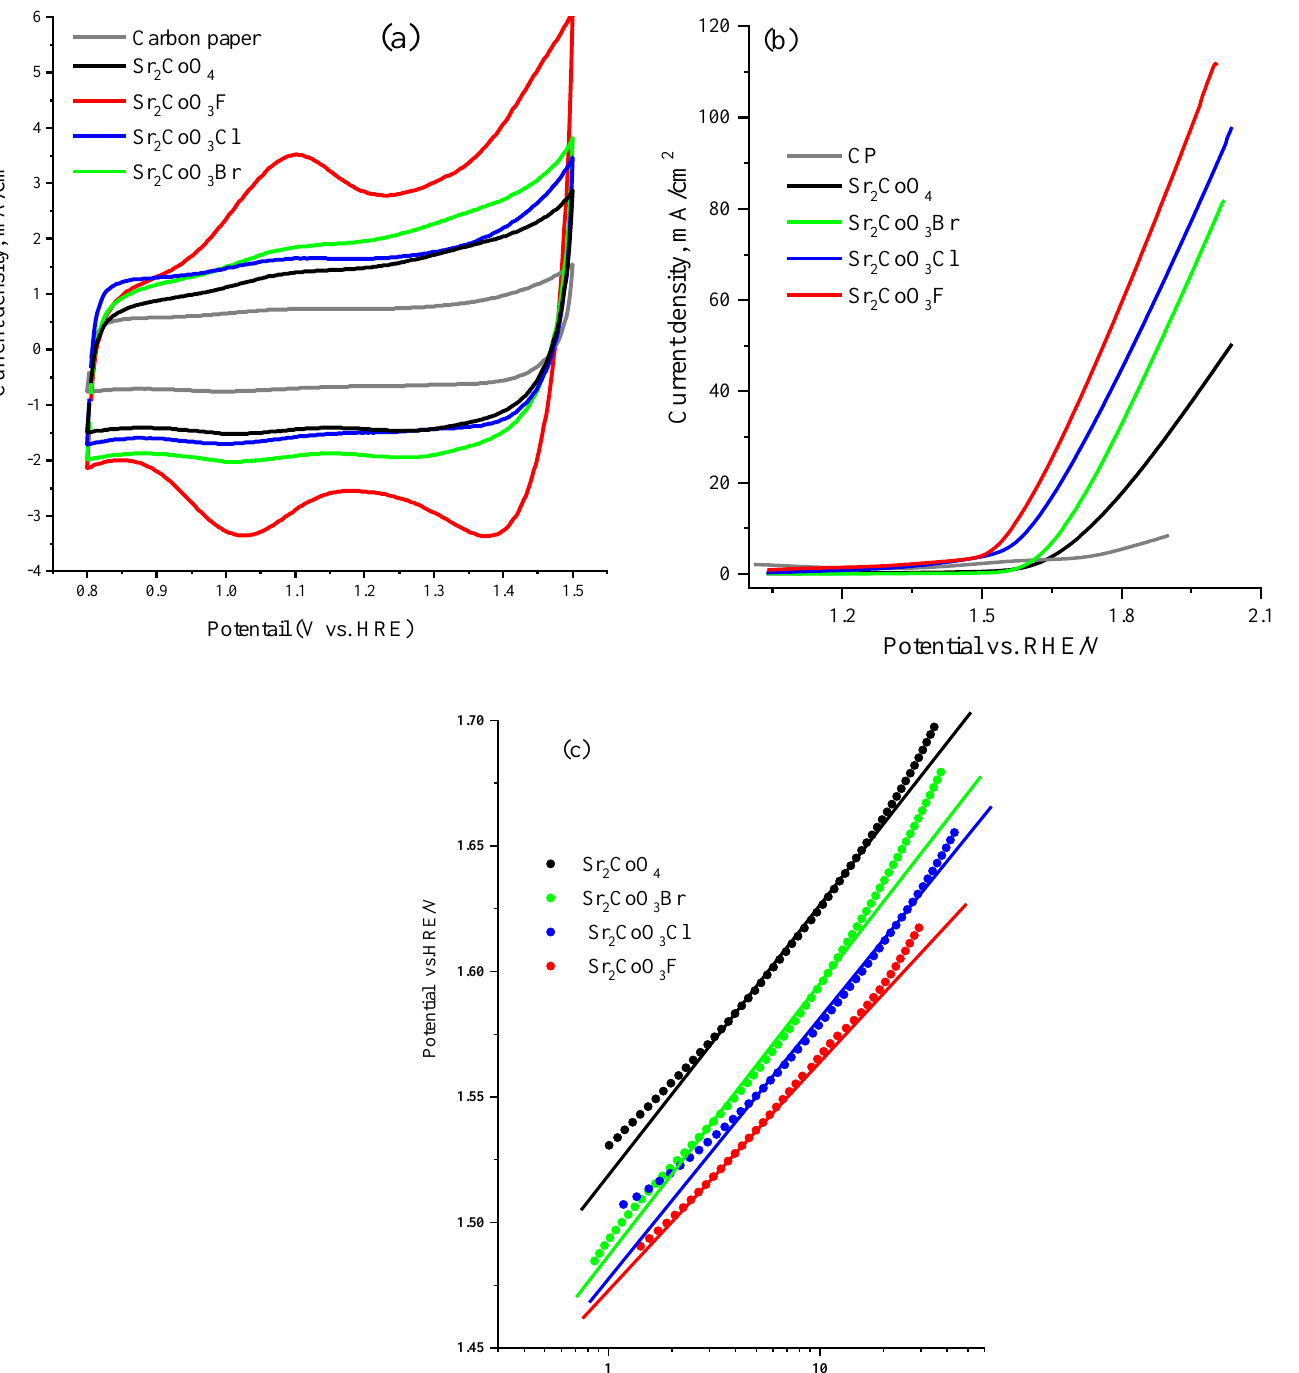
Figure 5. ( a ) cyclic voltammetry in the narrow potential window at 20 mV s − 1 for the strontium cobalt oxy-halide (Sr 2 CoO 3-x H x , H = F, Cl or Br and x = 1) catalysts in 1.0 M NaOH electrolyte and catalyst loading of 0.8 mg/cm 2 , ( b ) linear sweep voltammetry within OER region at 20 mV s − 1 for the strontium cobalt oxyhalides catalysts in 1.0 M NaOH electrolyte and catalyst loading = 0.8 mg cm − 2 , and ( c ) Tafel slopes of the oxyhalides catalysts as extracted from LSV shown in Figure S2 (supporting Information) and performed at a scan rate of 10 mV s − 1 and rotation rate of 1600 rpm. Table 3. The oxygen evolution onset potential and overpotential at a current density of 10 mA/cm 2 ( η 10% ) and Tafel slope of the strontium cobalt oxyhalides catalysts.